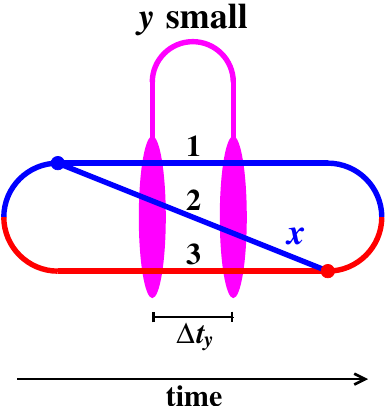
Figure 4 . The rate diagrams which (together with their complex conjugates) produce the double logarithm [10–12]. On each end, the relatively-soft y gluon may connect to any of the three lines of the underlying splitting process. In my analysis, all of the underlying lines will also be gluons. The magenta color of the y gluon is used here to indicate that it could be colored blue or red depending on whether its left-hand end is connected to a blue or red line,